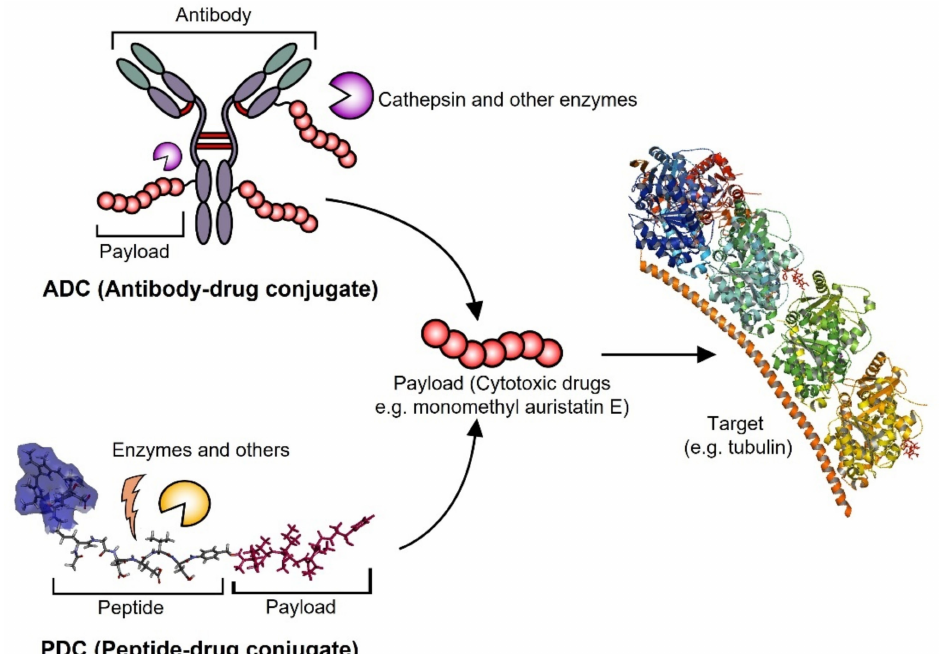
Figure 3. The concepts of antibody–drug conjugates (ADCs) and peptide–drug conjugates (PDCs) are fundamentally similar in drug-delivery systems. Strong cytotoxic drugs such as monomethyl auristatin E (MMAE), doxorubicin, and paclitaxel can bind to antibodies or peptides for targeting effects. In this case, conjugated MMAEs are released at the tumor site in anticancer therapy and then inhibit the same target (tubulin, PDB: 5IYZ) [42], leading to apoptosis in cancer cells. KLA (KLAKLAKKLAKLAK) is an interesting proapoptotic polypeptide that induces programmed cell death by disrupting the mitochondrial membrane. Bioconjugates incorpo- rating KLA peptides can be applied to the development of various anticancer